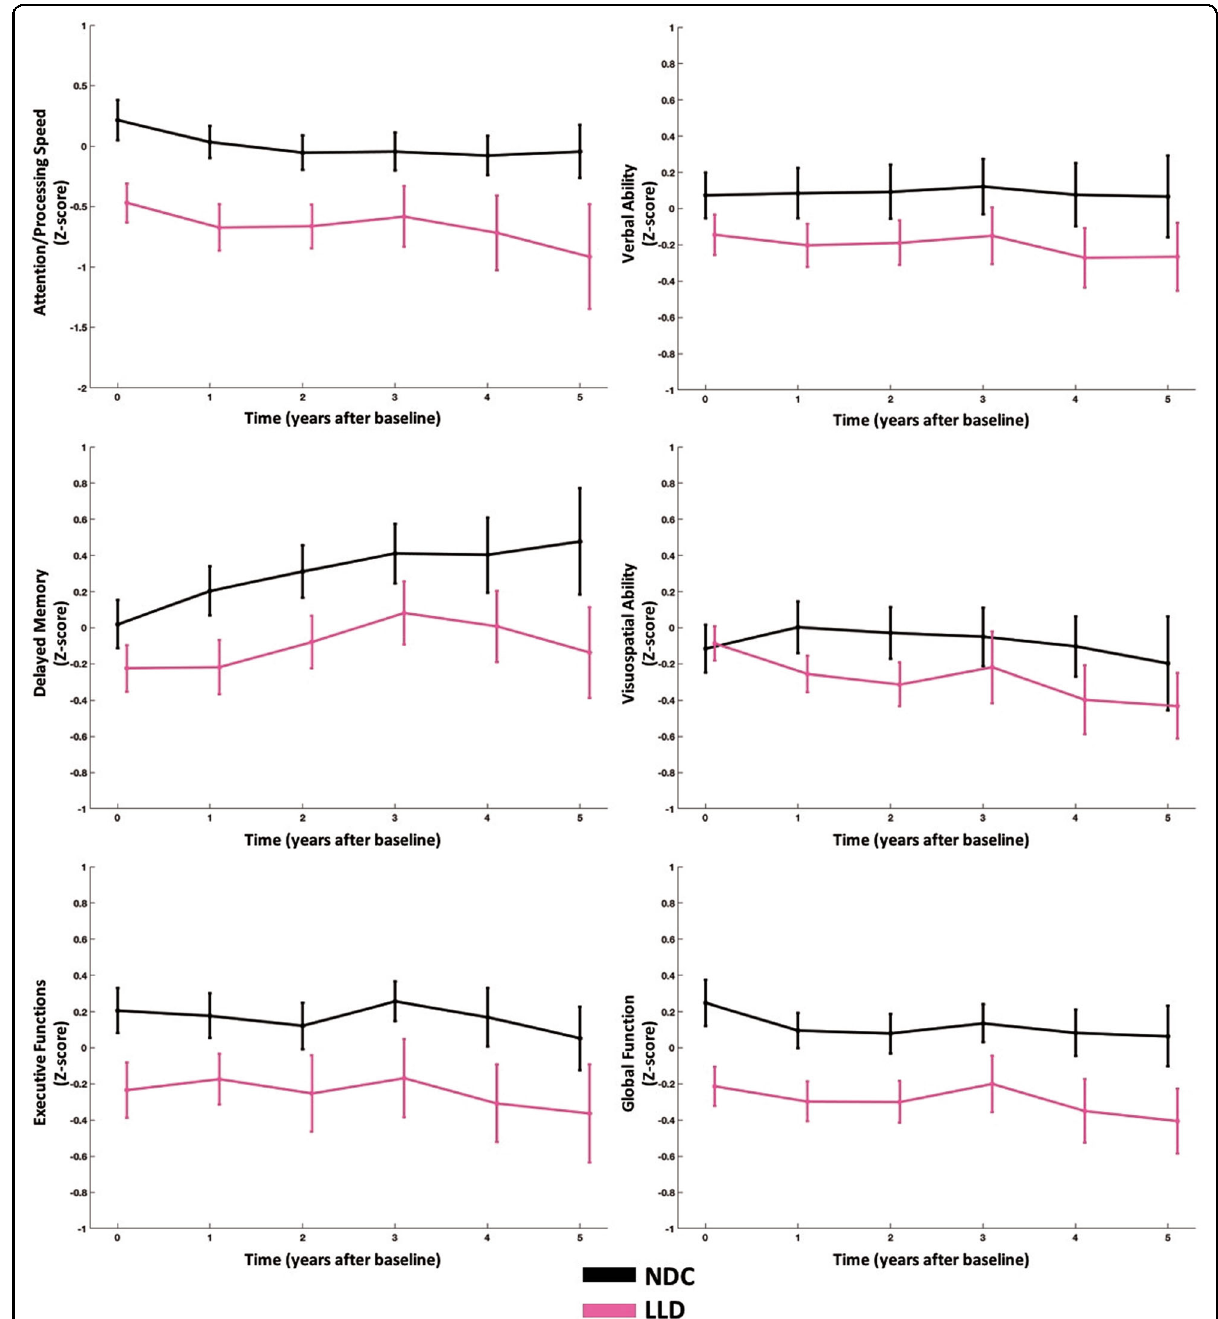
Fig. 1 Graph of cognitive trajectories comparing NDC vs. LLD. There were baseline differences between LLD and NDC in all domains except visuospatial ability. LLD group differed over time compared to the NDC in the verbal ability only — this may be due to lack of practice effect rather than cognitive